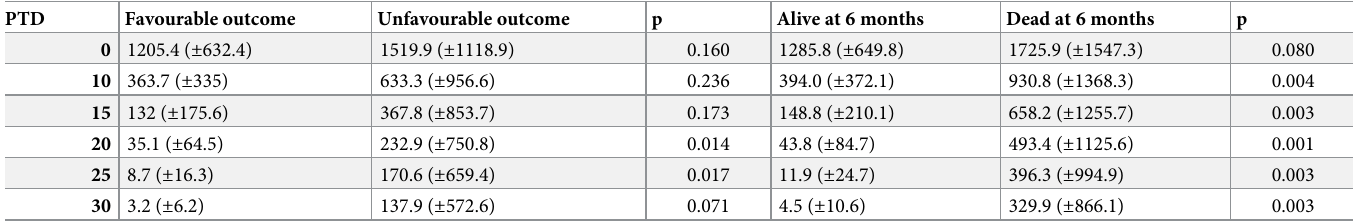
Table 2. Group mean PTD (mmHg � h) above thresholds of ICP. PTD Favourable outcome Unfavourable